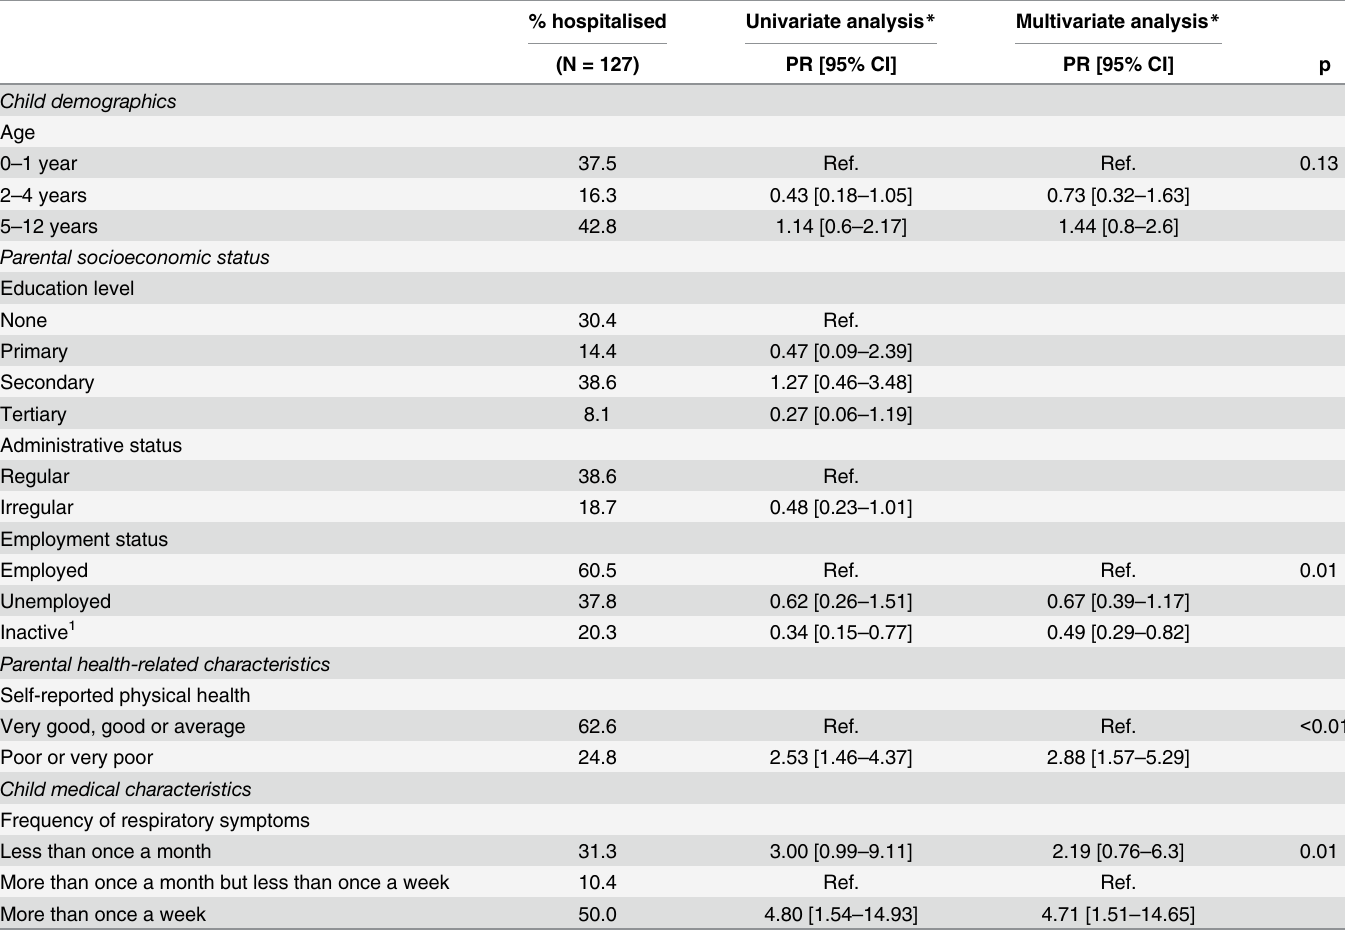
Table 5. Hospitalisations — bivariate and multivariate analyses